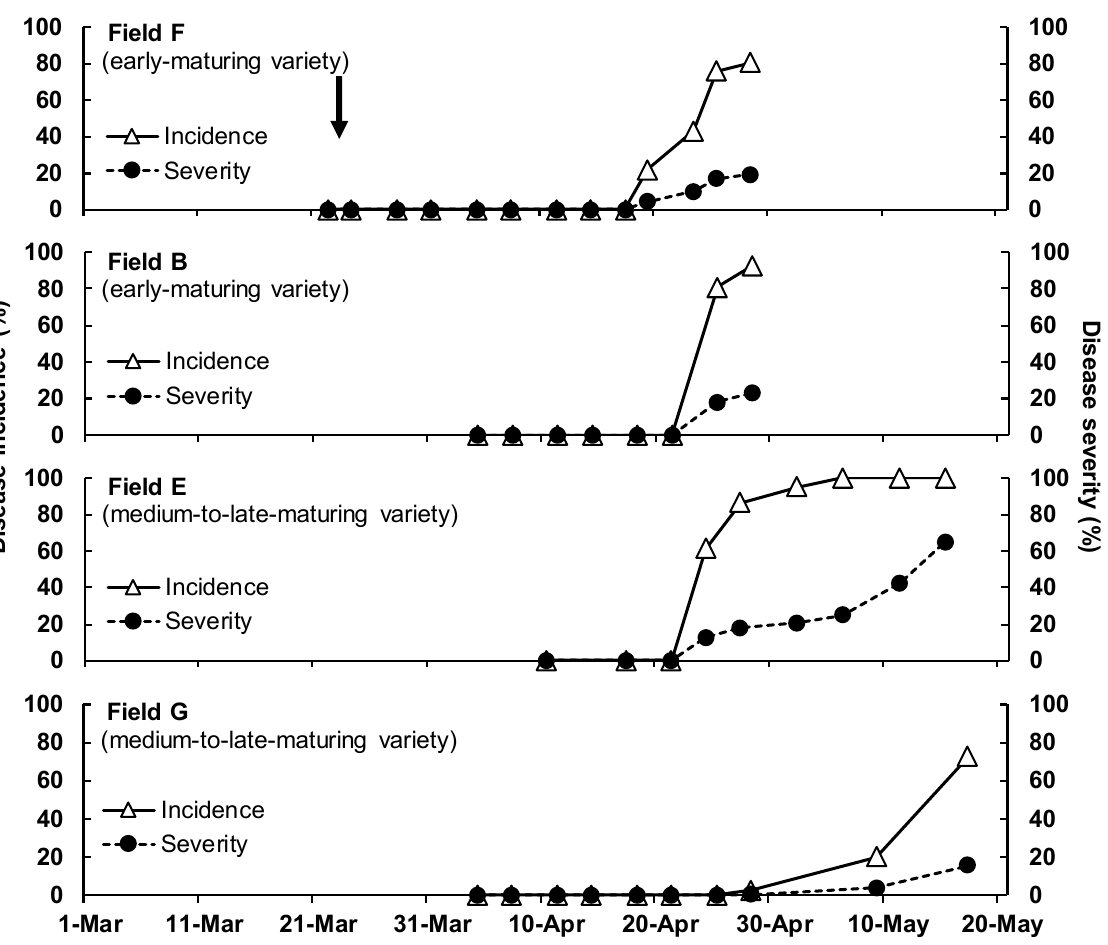
Figure 6. Development of onion downy mildew in unsprayed plots in 2017. In 2018, disease incidence and severity were the second-highest after 2016 (Figure 7). Favourable meteorological conditions occurred in early March (Table 3), but no disease symptoms were observed in late March. Disease symptoms were observed in Fields B, H, and I in early April after favourable meteorological conditions occurred from mid- to late March. After that, favourable meteorological conditions occurred in early April, and the disease incidences and severities in Fields B, H, and I and disease incidence in Field G increased from mid- to late April. In addition, the favourable meteorological conditions from mid- to late April subsequently led to increased disease incidence and severity in Field G from late April to early May.